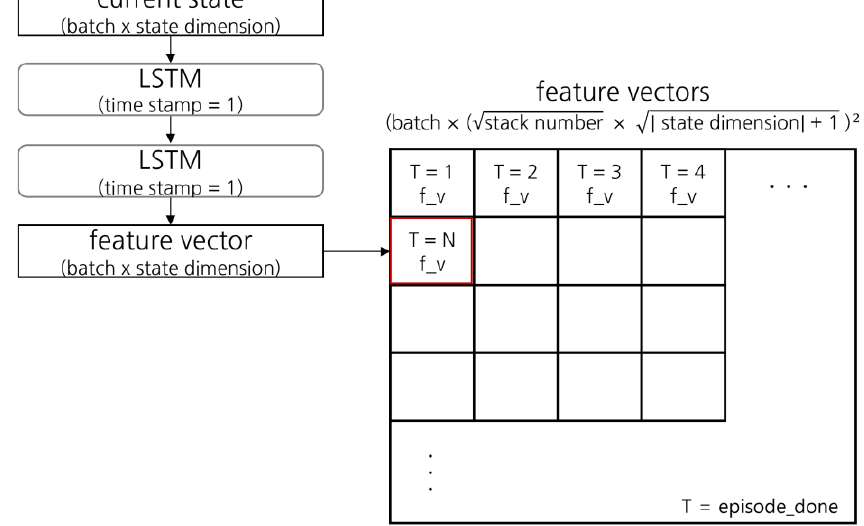
Figure 2. The sequence of feature vector generation. There are two fully connected layers. This means that learning consists of two